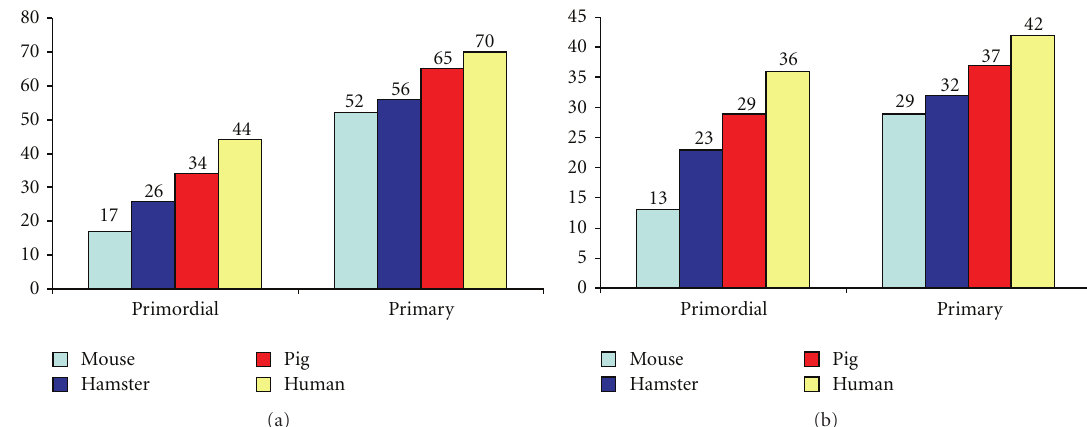
Figure 4: See [6, 10]. (a) Diameters of primordial follicles and primary follicles of 4 species. (b) Oocyte diameters in primordial follicles and primary oocytes of 4 species.